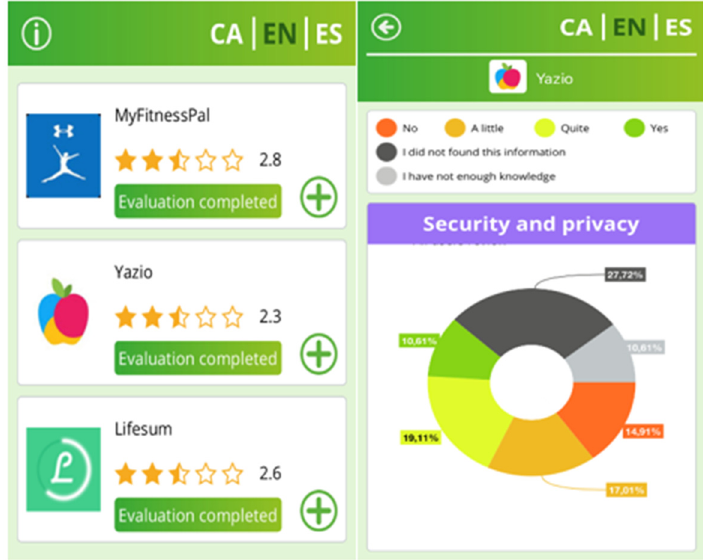
Figure 1. Screenshots of the Evalapps app.